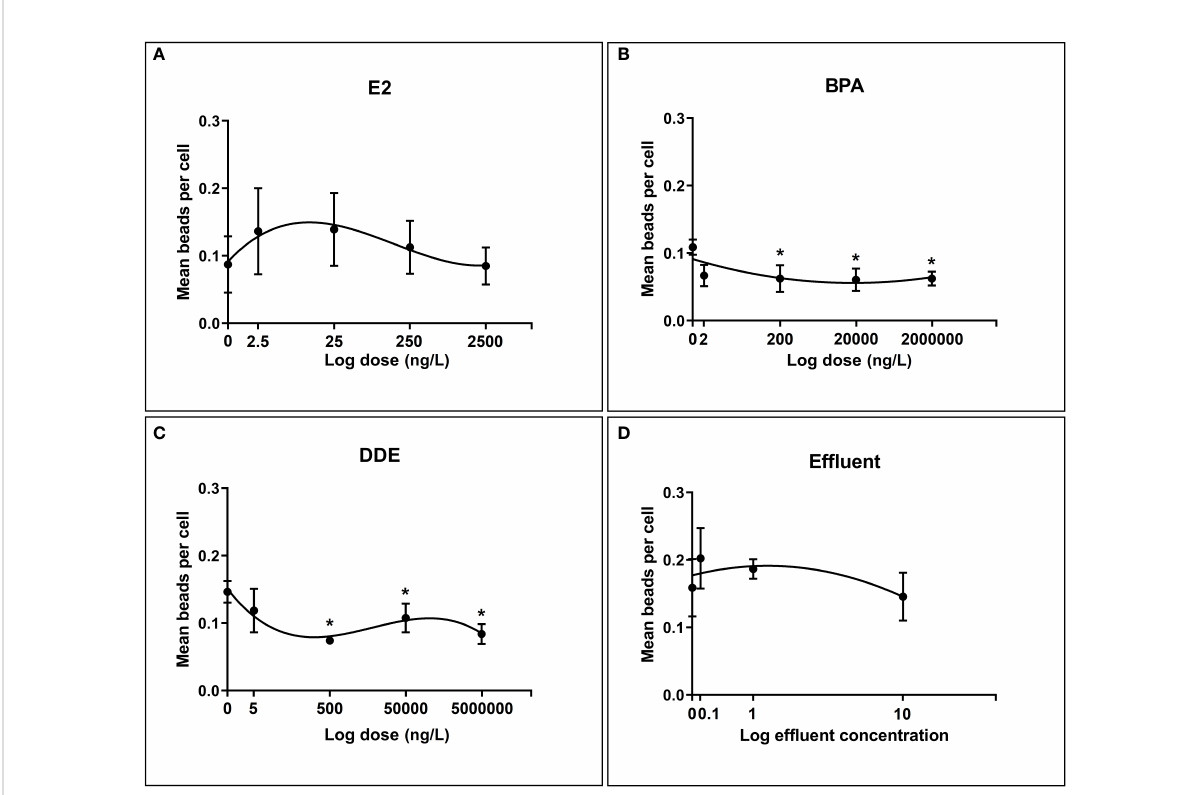
FIGURE 4 Regression relationships between log dose of test chemicals against phagocytosis of latex beads by B glabrata hemocytes exposed in vitro . Hemocyte response plotted as mean number of beads per cell ± SEM of four independent replicates. (A) Hemocyte phagocytosis response to E2 exposure (B) Hemocyte phagocytosis response to BPA exposure (C) Hemocyte phagocytosis response to Ef fl uent exposure (D) Hemocyte phagocytosis response to p,p ’ -DDE exposure. Asterisks (*) indicate signi fi cant differences relative to the control (p = < 0.05) according to Dunnett ’ s test for multiple